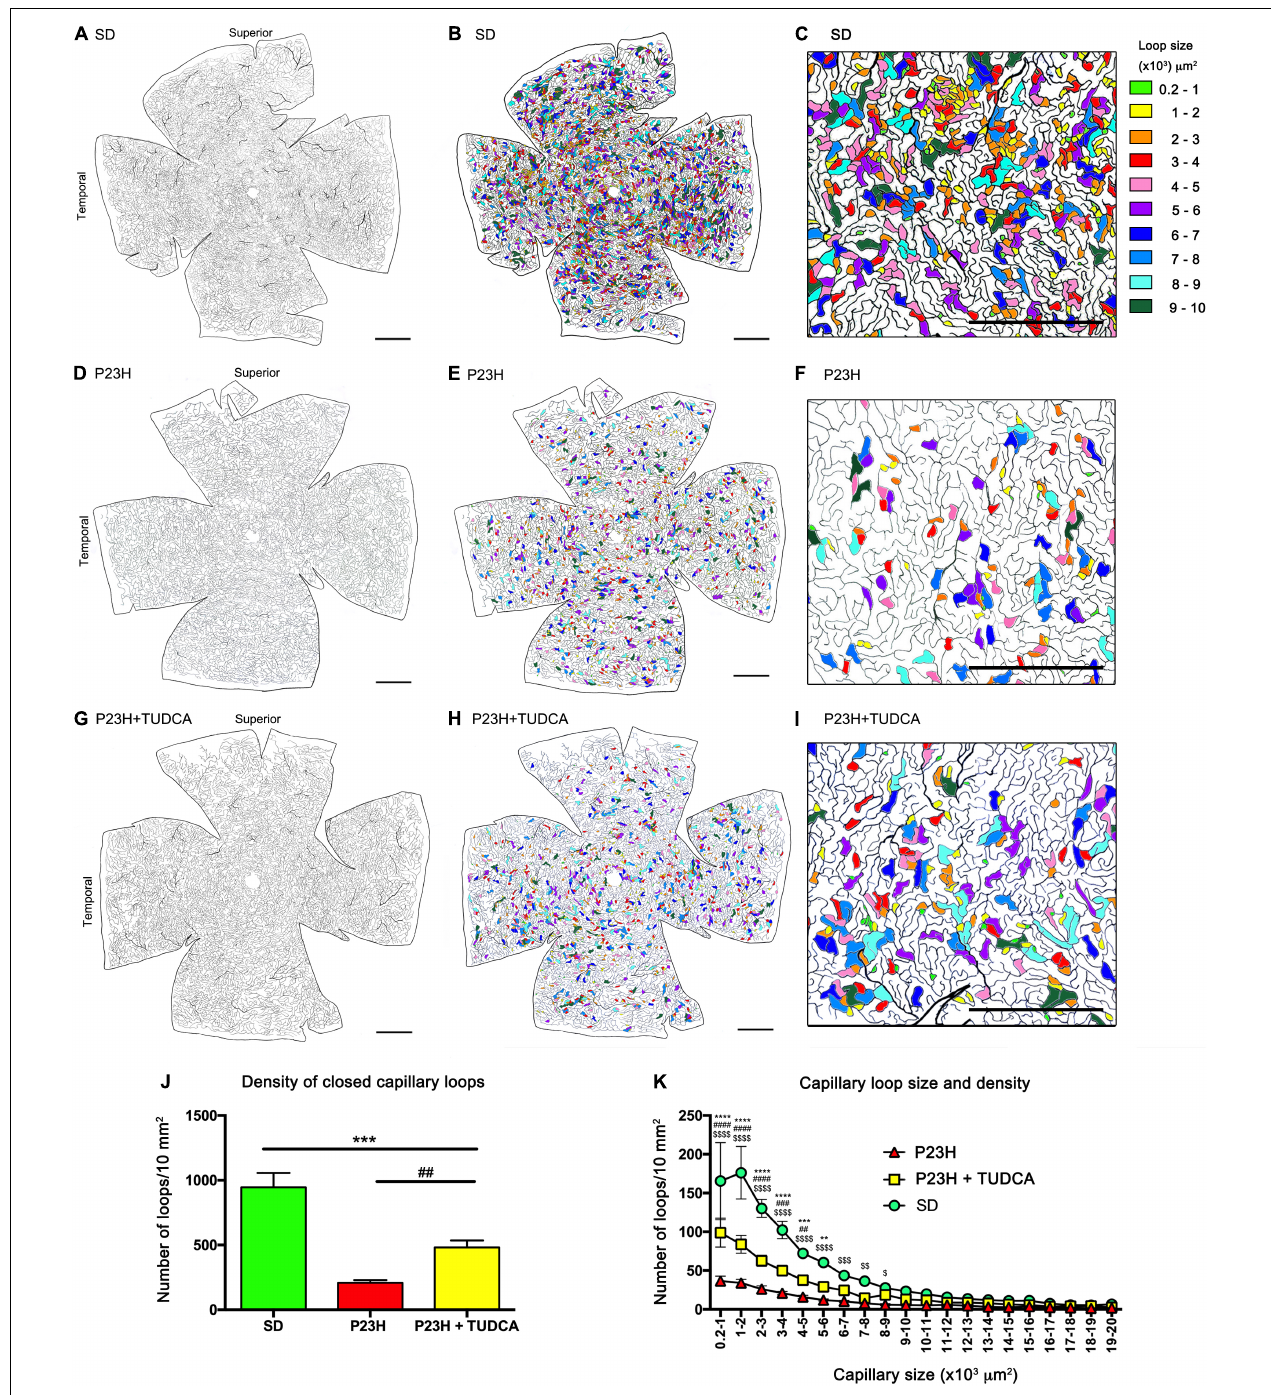
FIGURE 2 | Tauroursodeoxicholic acid (TUDCA) effects on degenerative changes in the deep capillary plexus. (A–I) Representative drawings of the DCP vessels from an SD (A–C) , P23H (D–F) , and TUDCA-treated P23H (G–I) rat at P120. The retinal area circumscribed by each enclosed capillary loop had been labeled in different colors according to their size (B,E,H) . Magnifications (C,F,I) correspond to the medial region of the temporal retina. The images showed a marked reduction in the number of closed capillary loops in P23H compared to SD retinas. These differences are less evident in retinas from TUDCA treated P23H animals. (J) Mean density of closed capillary loops in the DCP of SD, P23H, and TUDCA-treated P23H rats at P120. Note the high decrease in the number of closed loops in P23H retinas and the protective effect of TUDCA. (K) Relationship between closed capillary loop size and density in the same retinas than in (J) . Note that the relative loss of closed capillary loops in P23H rats was inversely proportional to the loop size. One-way (J) and two-way (K) ANOVA, Tukey’s multiple comparison test; TUDCA-treated P23H vs. SD: ** p < 0.01, *** p < 0.001, **** p < 0.0001; TUDCA-treated vs. vehicle-treated P23H: ## p < 0.01, ### p < 0.001, #### p < 0.0001; vehicle-treated P23H vs. SD: $ p < 0.05, $$ p < 0.01, $$$ p < 0.001, $$$$ p < 0.0001. SD, n = 3; P23H, n = 7; P23H + TUDCA, n = 6. Scale bars : 1